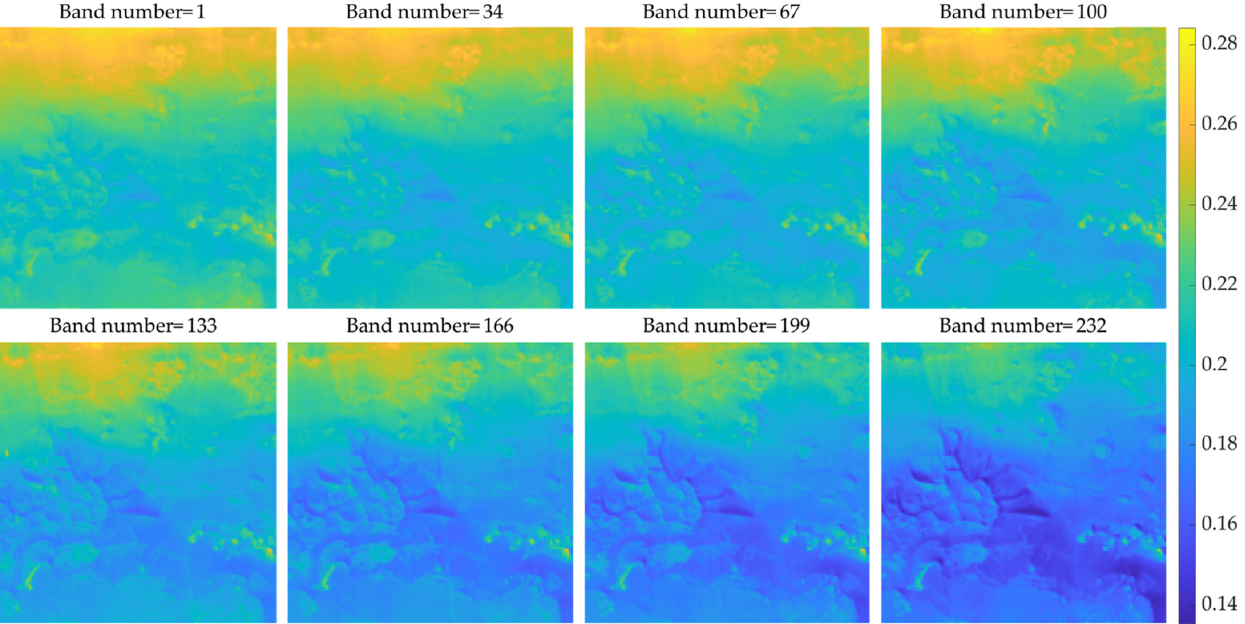
Figure A2. Comparison of 8 bands of frt000128d0_07_if165l_trr3 low-resolution data.